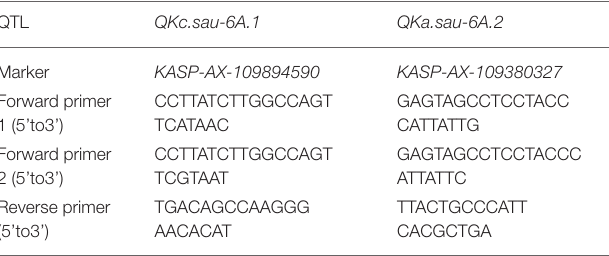
TABLE 4 | Kompetitive allele-specific PCR markers for QKc.sau-6A.1 and QKa.sau-6A.2